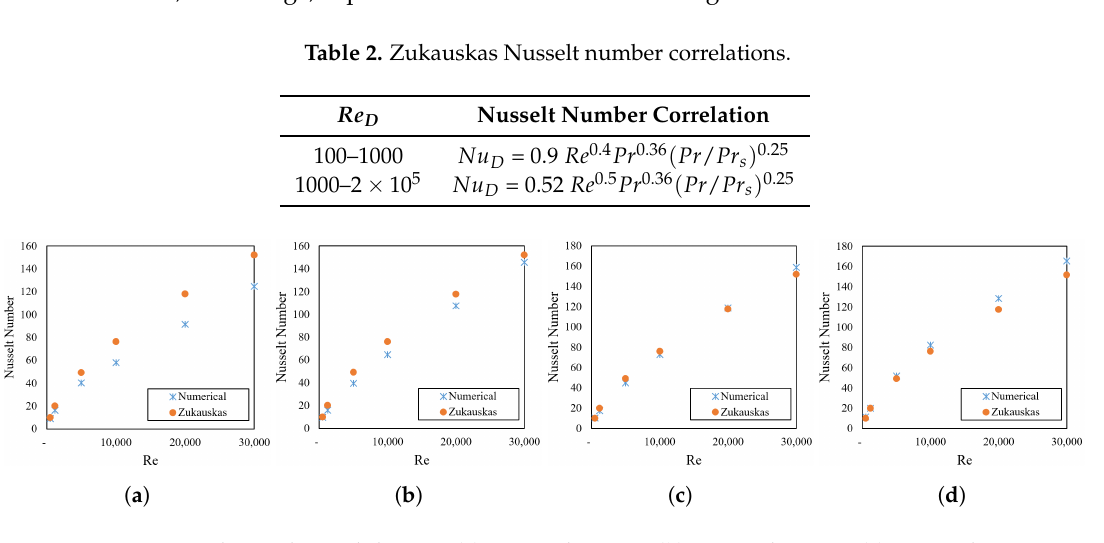
Figure 6. Nusselt number validation. ( a ) 1.3 Pitch Ratio; ( b ) 1.6 Pitch Ratio; ( c ) 2.0 Pitch Ratio; ( d ) 3.0 Pitch